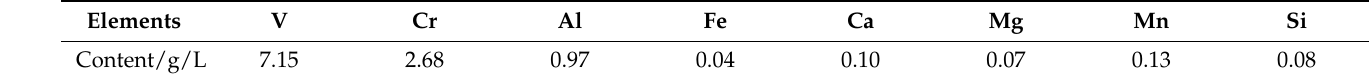
Table 4. Chemical composition of four-stage countercurrent stripping